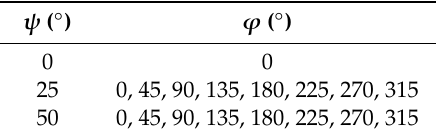
Table 3. Di ff erent sample orientations Table 3. Different sample orientations [27].